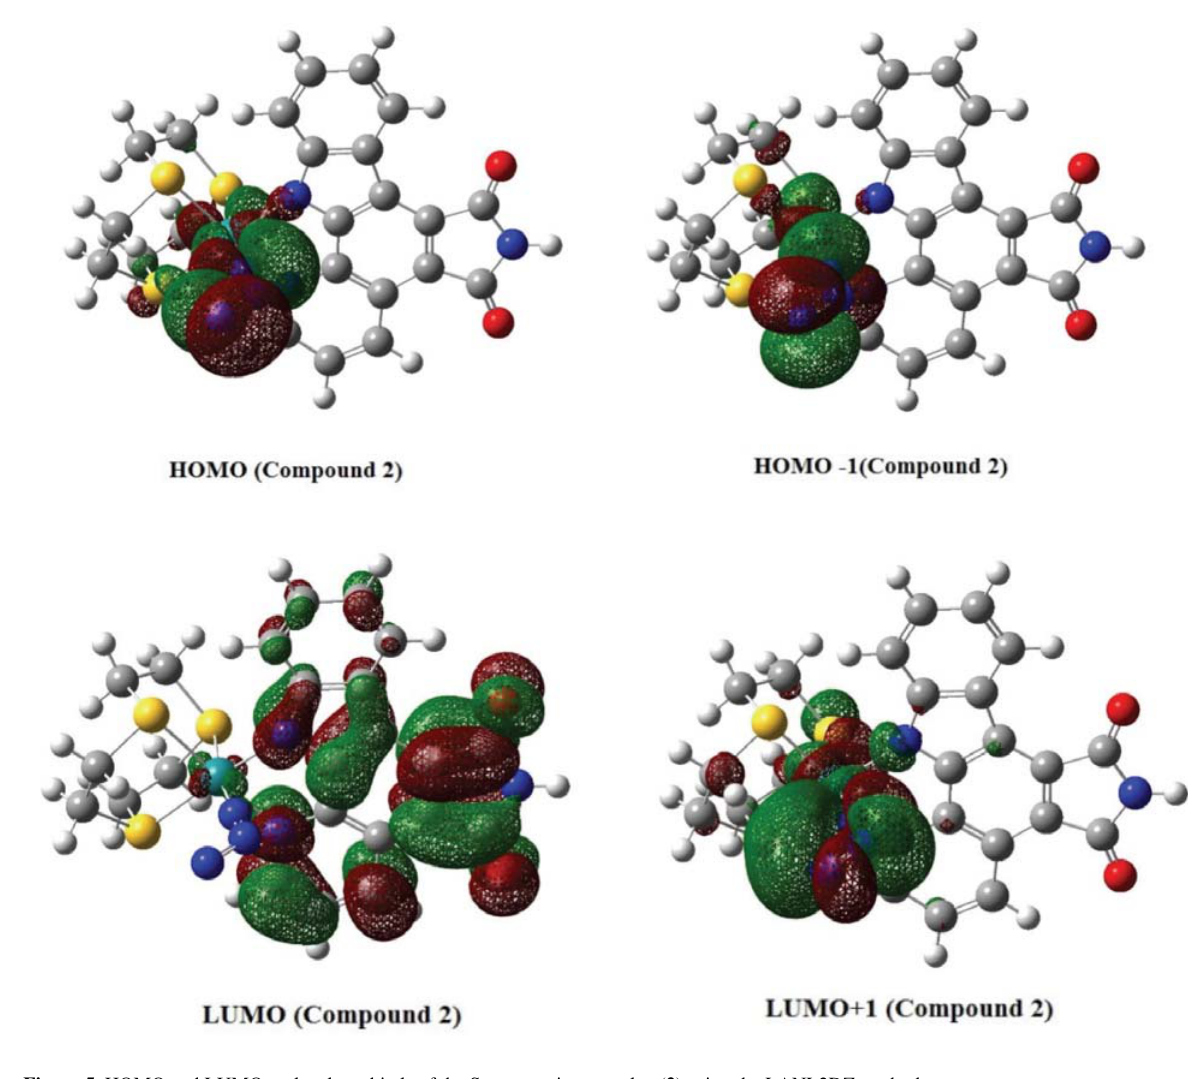
Figure 5. HOMO and LUMO molecular orbitals of the Staurosporine complex ( 2 ) using the LANL2DZ